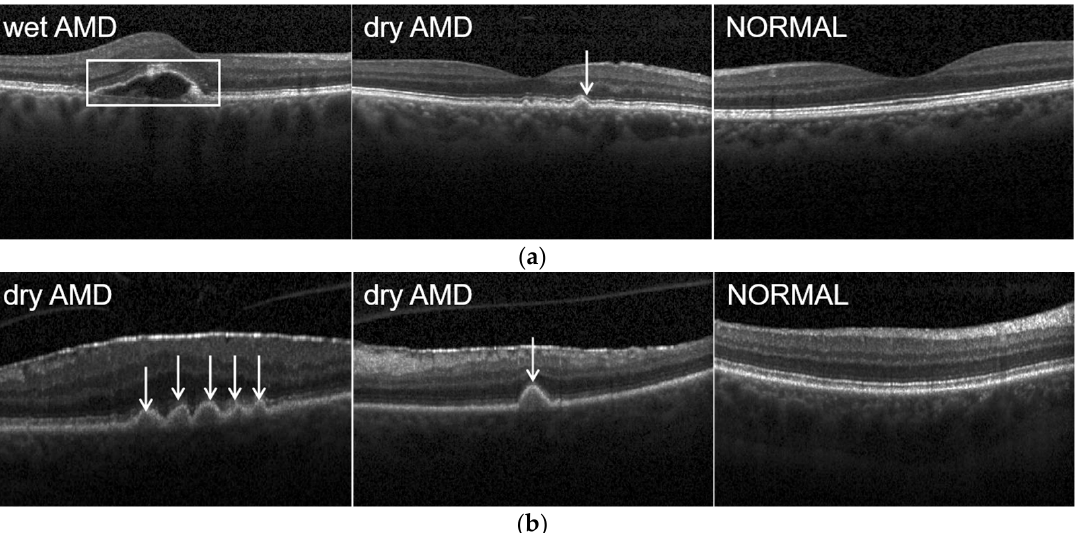
Figure 5. Sample images: ( a ) belongs to the UCSD dataset; ( b ) belongs to the Duke dataset. The white arrows point to drusens in the dry AMD, and the white box shows the irregular blood vessel under the macula in the wet AMD.